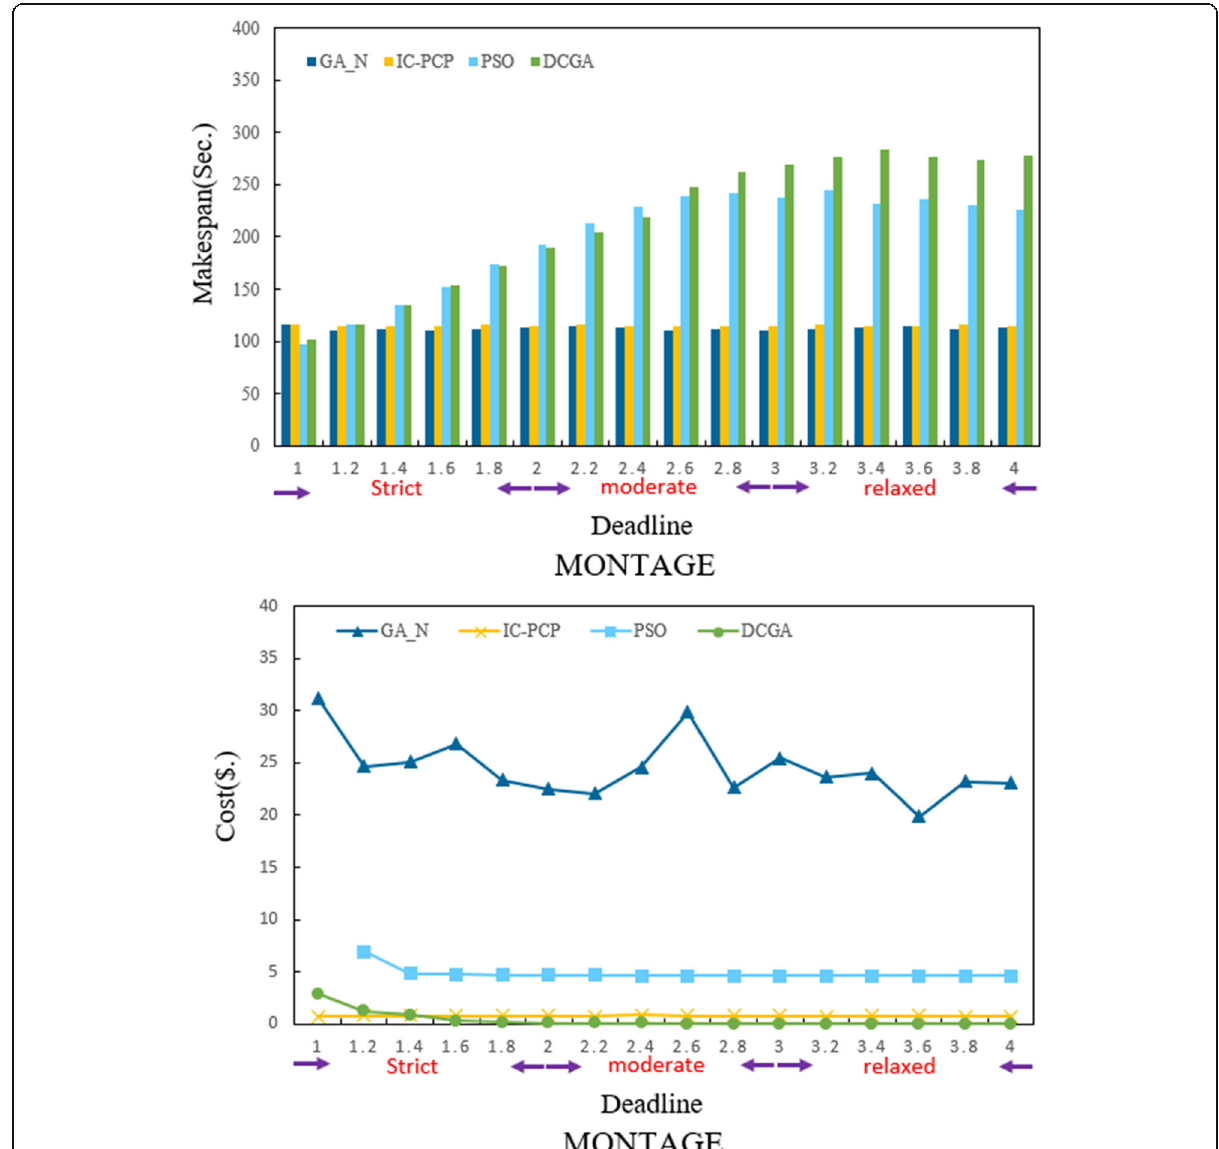
Fig. 8 Makespan and cost of scheduling on MONTAGE under different deadline